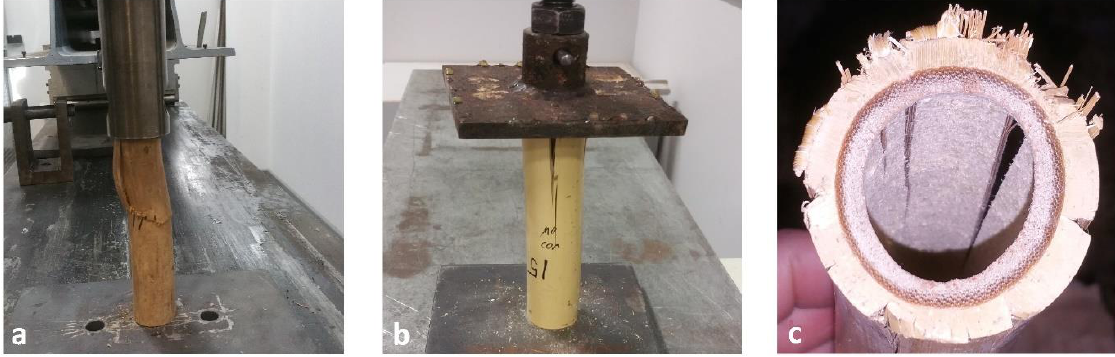
Figure 9. Pictures of specimen fractures after compression tests: ( a ) DS, ( b ) PA, and ( c ) AA.